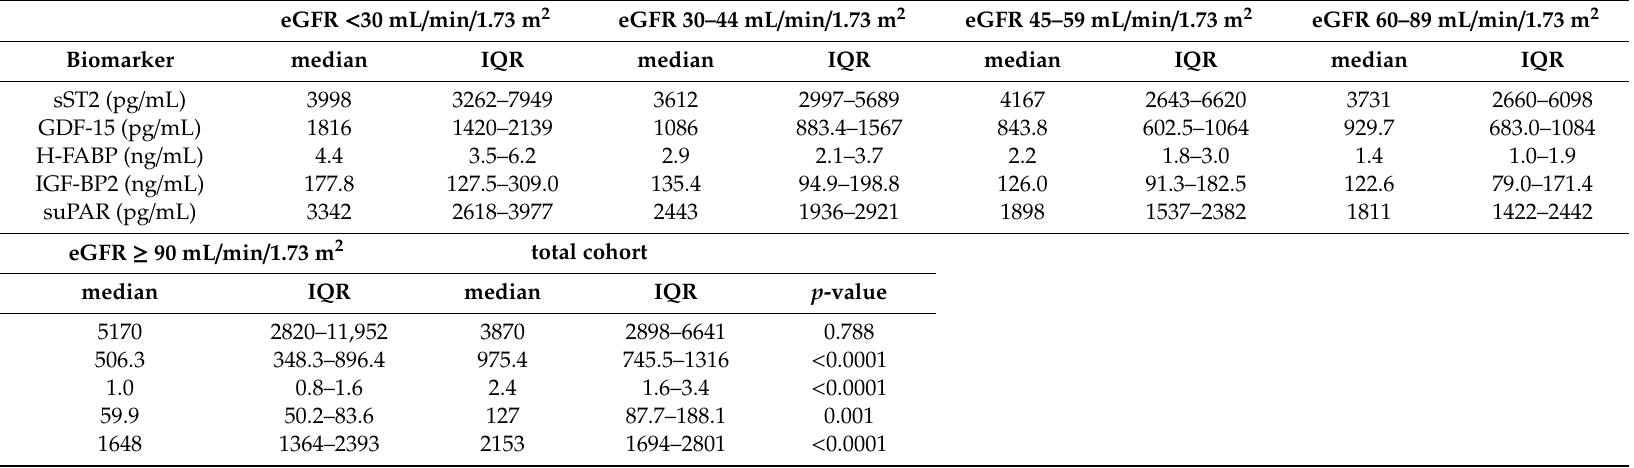
Table A1. Biomarker concentrations by estimated glomerular filtration rate (eGFR).